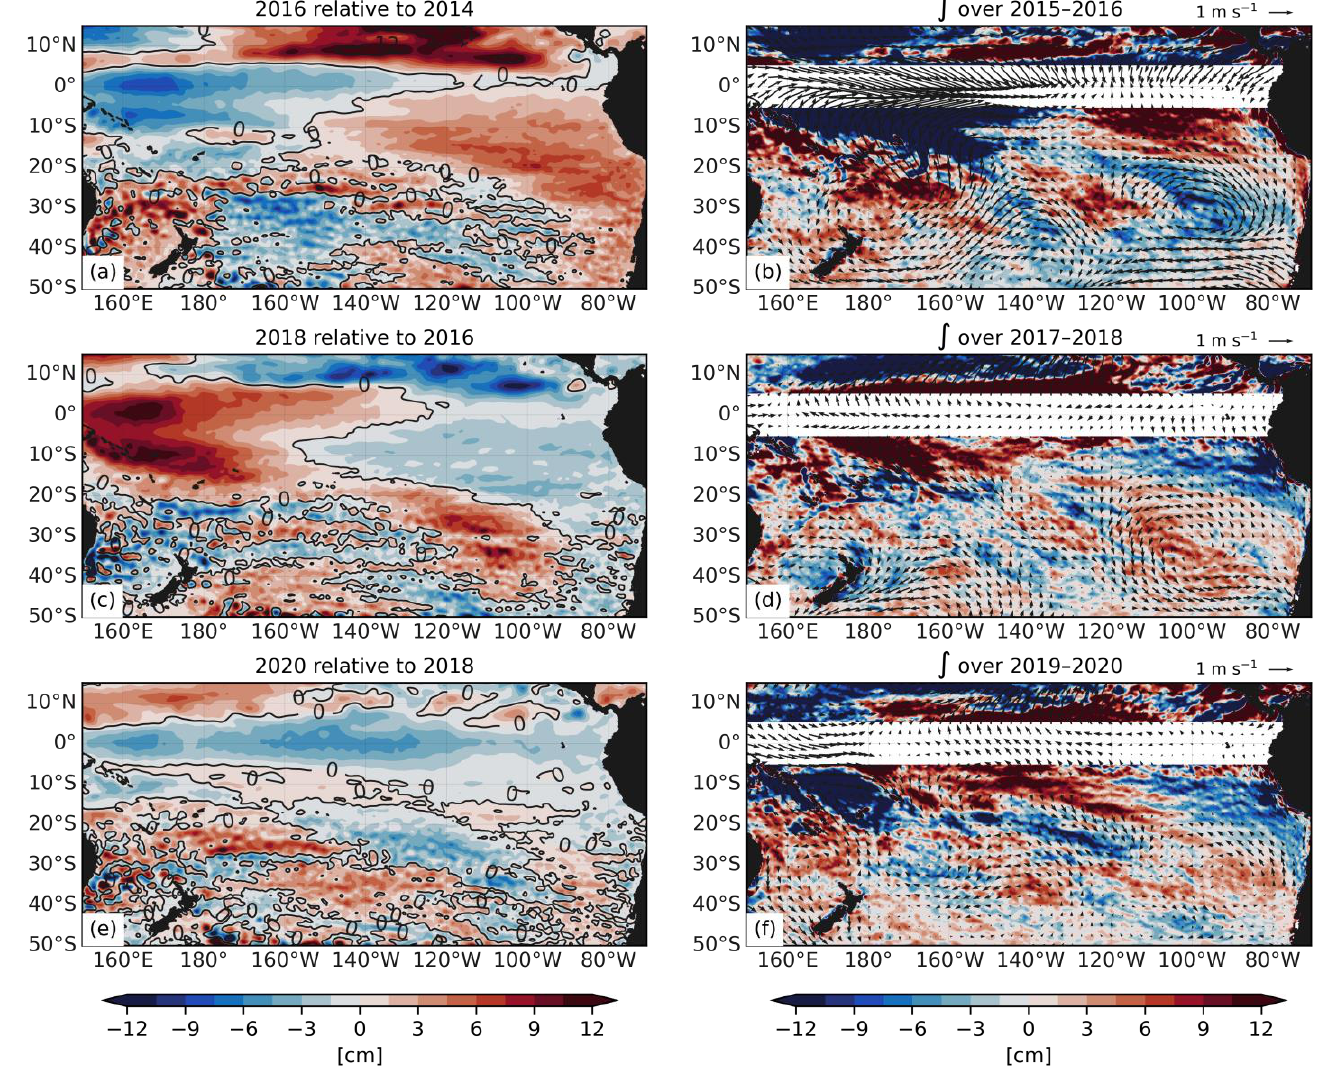
Figure 2. Differences in sea level anomaly (SLA) derived from satellite altimetry: ( a ) 2016 minus 2014, ( c ) 2018 minus 2016 and ( e ) 2020 minus 2018. The Ekman solution ∆ h Ek (color; see Equation (2)) is computed by integrating over time the Ekman pumping anomalies W Ek relative to the 1993–2020 time mean over ( b ) 2015–2016, ( d ) 2017–2018 and ( f ) 2019–2020. The 5 ◦ S–5 ◦ N region is excluded from the computation because the Coriolis parameter tends towards zero near the equator, thereby Ekman pumping cannot be properly determined. The 10-m wind velocity anomalies (relative to the 1993–2020 time mean) averaged over ( b ) 2015–2016, ( d ) 2017–2018 and ( f ) 2019–2020 are shown by the arrows.